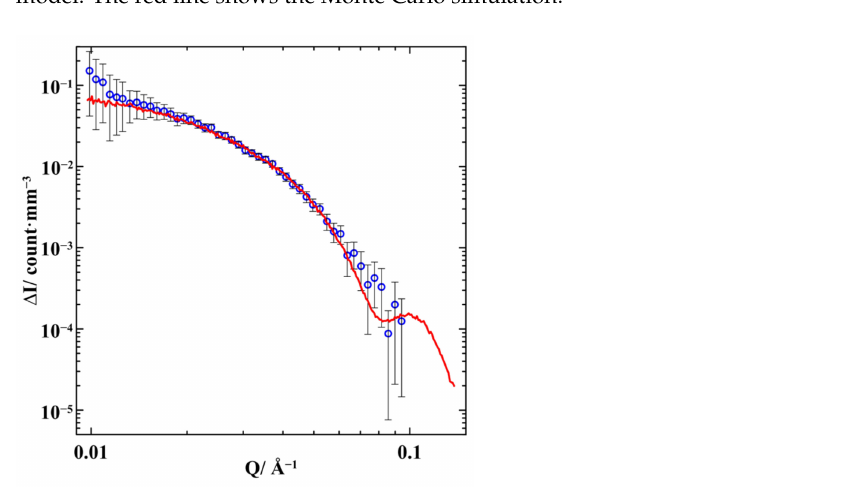
Figure 5. The difference ∆ I ( Q ) of the SANS intensities by G6 and G4. The red line shows the Monte Carlo simulation for the indium-rich segregates with a shape of prolate ellipsoids of revolution with semi-axes of 17 and 5.3